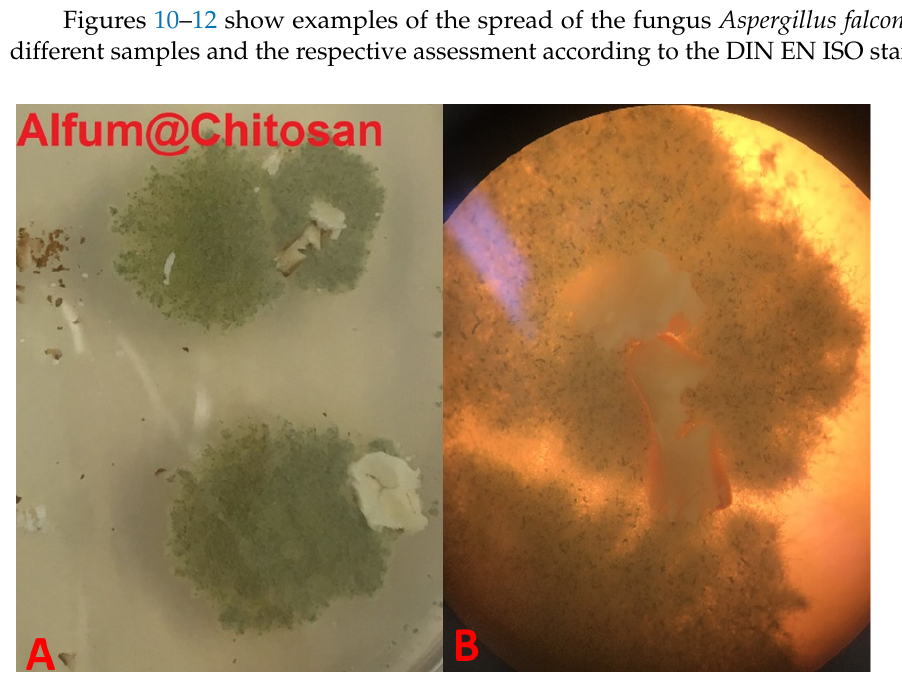
Composite Material